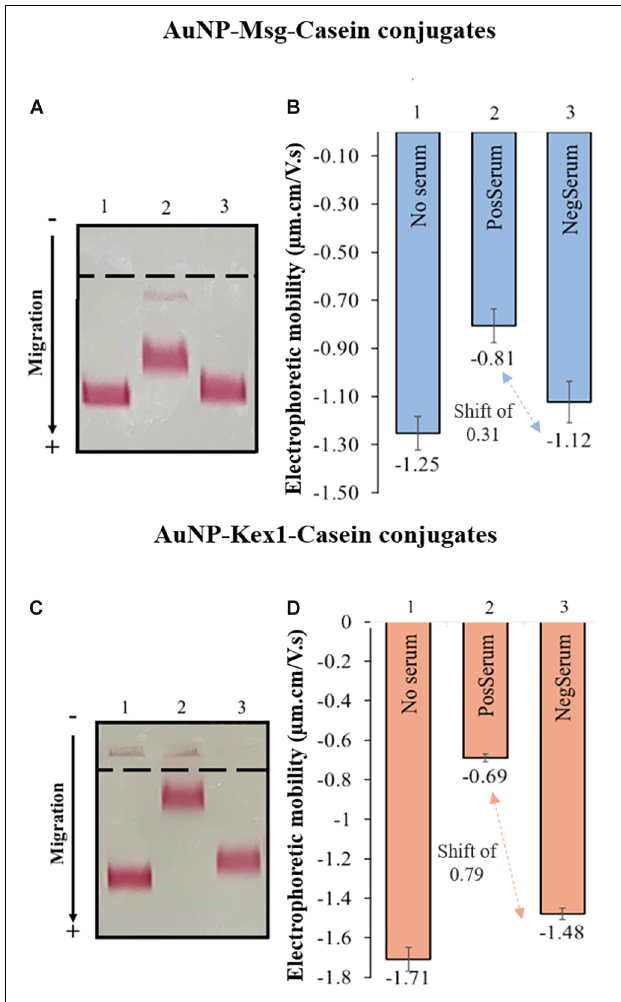
FIGURE 5 | Interaction of AuNP-Msg-Casein (A,B) and AuNP-Kex1-Casein conjugates (C,D) with sera pools from patients with and without P. jirovecii infection. (A,C) Agarose gel electrophoresis of AuNP-RSA-Casein conjugates before interaction with serum (1) and after interaction with positive (2) and negative (3) serum samples. (B) Electrophoretic mobility of the AuNP-RSA-Casein conjugates before interaction with human sera (No Serum) and after interaction with the positive human sera (PosSerum) and negative human sera (NegSerum). Shifts ( µ m.cm/V.s) between blocked conjugates with positive and with negative sera are indicated, evidencing the binding of antibodies present in the positive serum. Standard deviation bars correspond to triplicate